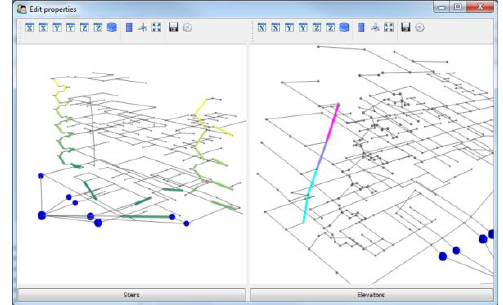
Figure 4. Visualization of the integrated indoor